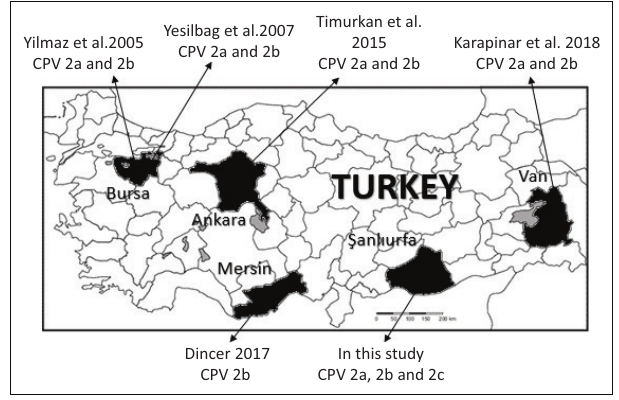
FIGURE 1: Illustrative map of canine parvovirus-2 variant (2a/2b/2c) locations in the studies.